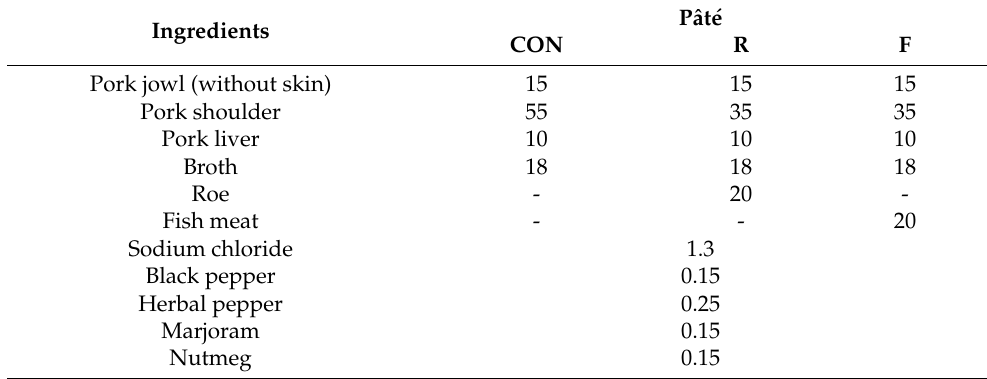
Table 1. Composition of pork p â t é s